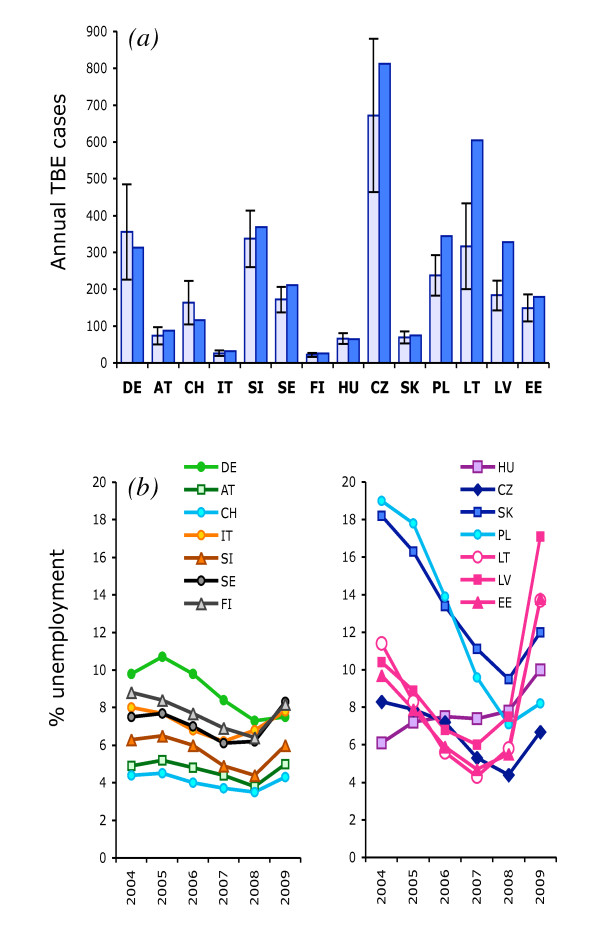
Recent trends in tick-borne encephalitis cases and unemployment across Europe. A) The number of cases of tick-borne encephalitis in 2009 (solid bars) relative to the mean numbers +/- 1StDev for 2004-2008 (light bars) for the same countries. B) Trends in the annual levels of unemployment (see text for precise metric) from 2004 to 2009 in 14 European countries. (Countries are divided into roughly geo-political groups simply for visual clarity.) DE Germany, AT Austria, CH Switzerland, IT Italy, SI Slovenia, SE Sweden, FI Finland, HU Hungary, CZ Czech Republic, SK Slovakia, PL Poland, LT Lithuania, LV Latvia, EE Estonia.